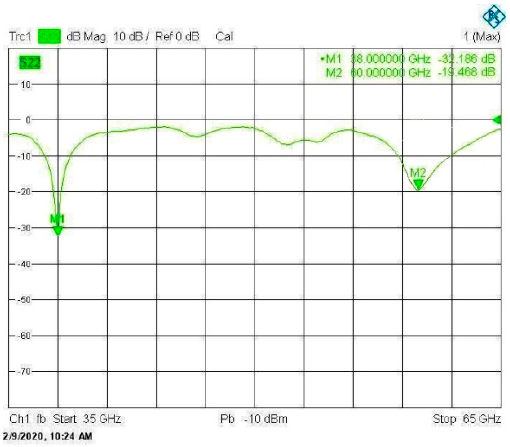
Figure 14. The measured frequency response of the scattering parameter | S 11 | of the VNA.